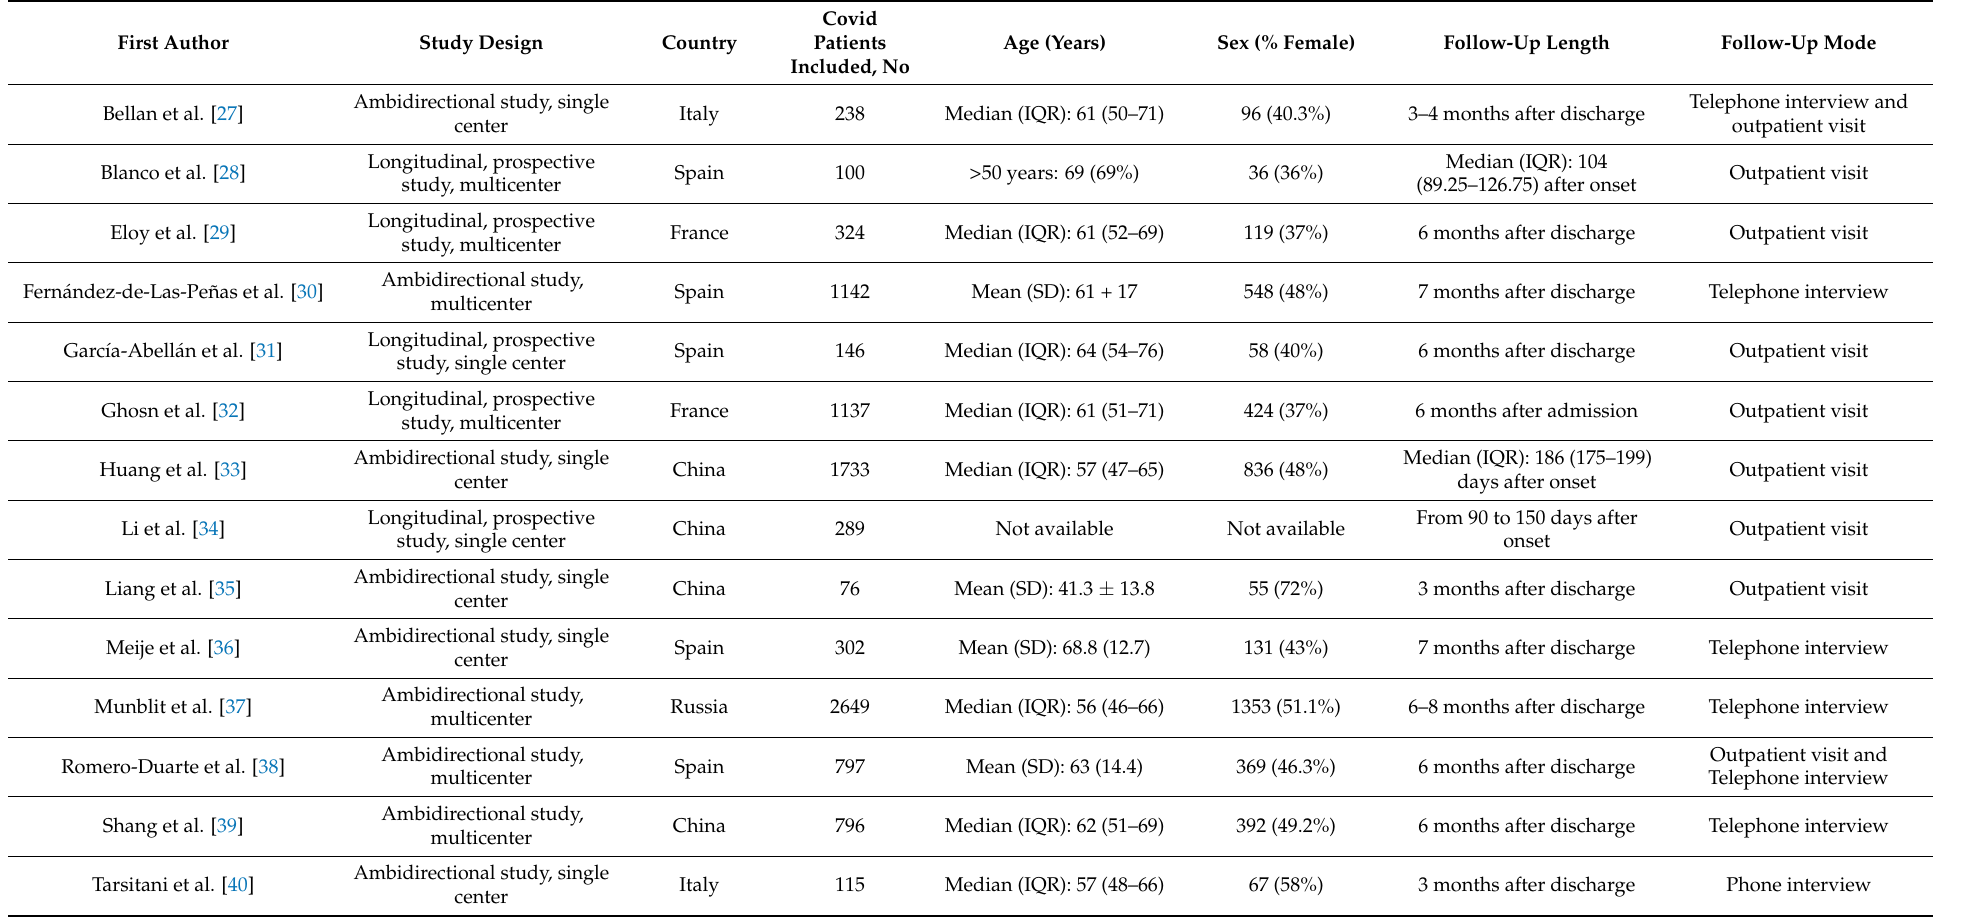
Table 1. Characteristics of included